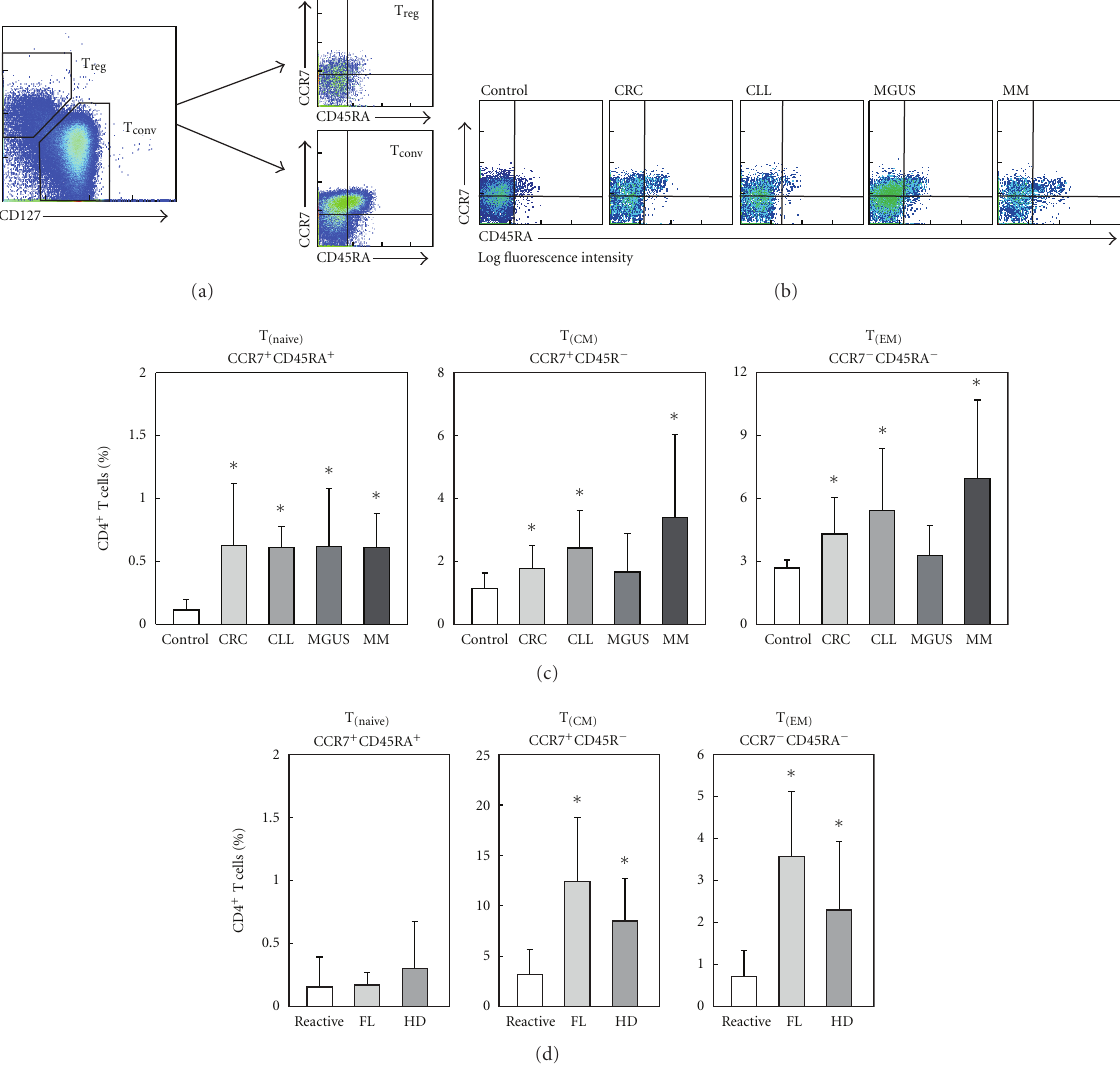
Figure 5: Assessment of na¨ıve CCR7 + CD45RA + CD4 + CD127 low FOXP3 + T reg cells. (a) Frequencies of CCR7 + CD45RA + na¨ıve CD4 + CD127 low FOXP3 + T reg cells (T naive ), CCR7 + CD45RA − CD4 + CD127 low FOXP3 + central memory T reg cells (T CM ), and CCR7 − CD45RA − CD4 + CD127 low FOXP3 + e ff ector memory T reg cells (T EM ) were assessed in peripheral blood using gating on CD127 and FOXP3 with successive gating on CCR7 and CD45RA. (b) Flow cytometric analysis of na¨ıve, central memory, and e ff ector memory CD4 + CD127 low FOXP3 + T reg cells in peripheral blood from a representative healthy individual (control) as well as representative patients with colorectal cancer (CRC), CLL, MGUS, and multiple myeloma (MM). Frequencies of regulatory T naive , T CM , and T EM cells were assessed in (c) peripheral blood of CRC (CRC, n = 12), CLL (CLL, n = 10), MGUS (MGUS, n = 7), MM (MM, n = 10), and healthy individuals (control, n = 10) and (d) 7 reactive lymph node biopsies from healthy individuals (reactive), 7 patients with follicular lymphoma (FL), and 6 patients with Hodgkin’s disease (HD). Error bars represent standard deviation ( ∗ , P < 0 . 05, Student’s t-